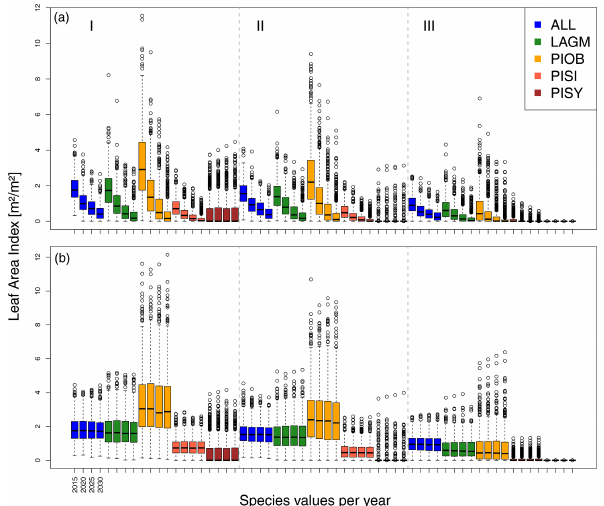
Figure 6. Leaf area index (LAI) values at Nyurba for three areas within the simulation areas (I, II, III) on the same plot at which CryoGrid was called (upper row) and only LAVESI runs (lower row). LAGM: Larix gmelinii ; PIOB: Picea obovata ; PISI: Pinus sibirica ; PISY: Pinus sylvestris